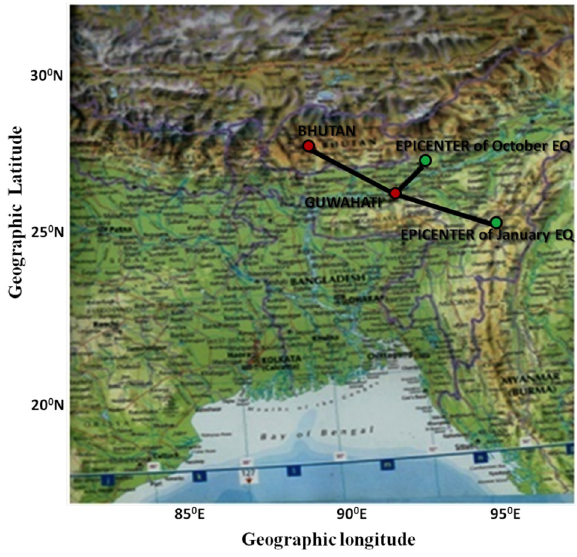
Figure 4. Map showing transmitter (at Bhutan) and receiver (at Guwahati) locations (red circle); the epicenter positions are marked by green circles.